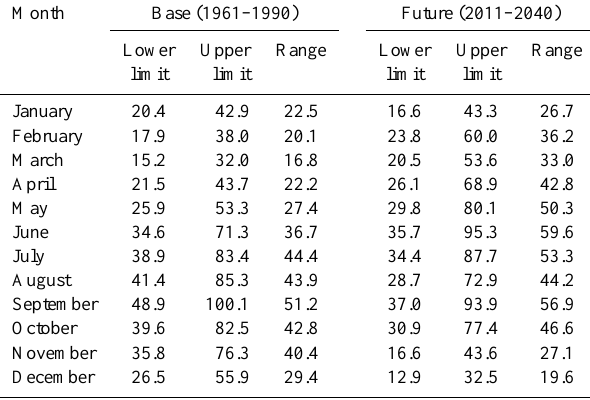
Table 6. Limits and ranges of the confidence interval of flows (m 3 s − 1 ) with 90% permanence ( Q 90 ) in the base period (1961– 1990) and future period (2011–2040), Santo Ângelo gauge